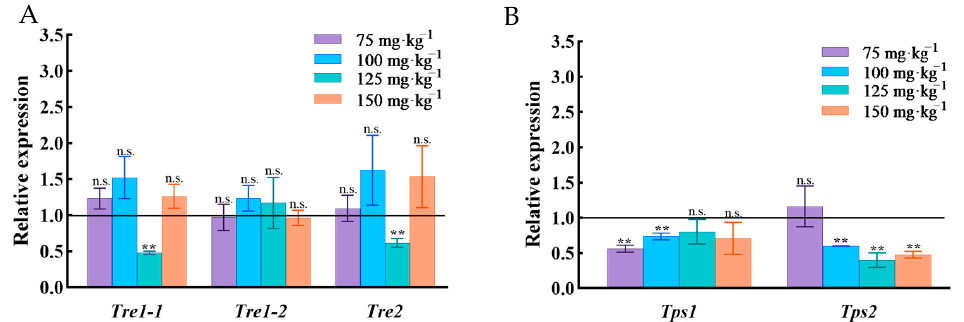
Figure 7. Effects of Zn accumulation in rice plants on the expression of Tre ( A ) and Tps ( B ) in N. lugens . The qRT-PCR was used to determine the relative expression of genes, and actin was used as the internal control. The horizontal line in the figure represents the gene expression level in the control group. Data are represented as mean ± SE ( n = 3), and the significance of differences in gene expression between the treatment and control groups was analyzed with t-tests. * p < 0.05; ** p < 0.01.